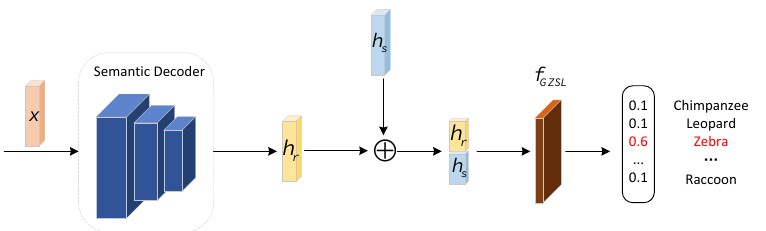
Figure 2. Classification architecture. A feature transformation is performed by concatenating ( ⊕ ) the semantic-consistent features, h s , of the output of the disentanglement module with the semantic- consistent features, h r , of the output of semantic decoder module, Dec . The transformed discrimina- tive features are then used for GZSL